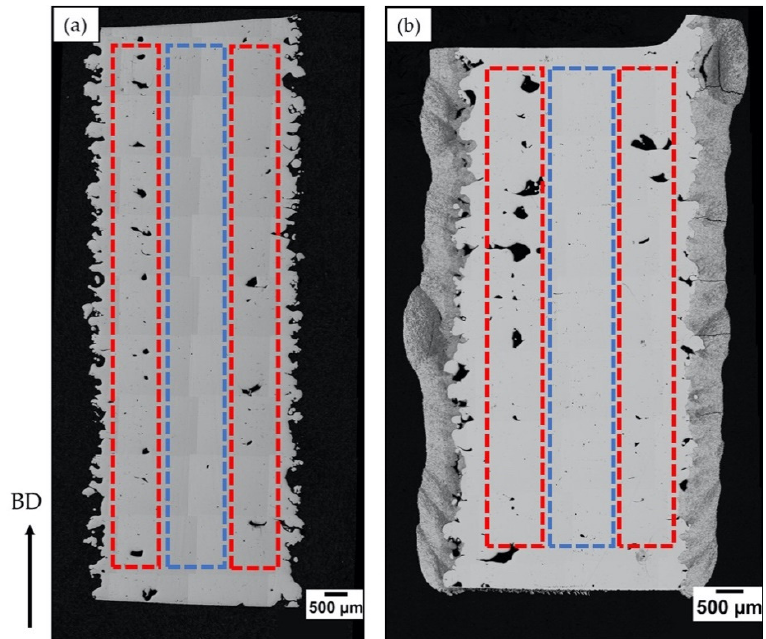
Figure 2. Light optical microscopy (LOM) micrographs of the specimen cross-sections in the ( a ) uncoated and ( b ) coated conditions. The dotted red and blue lines indicate the regions of contour and hatch, respectively, distinctly analyzed for defect quantification. The arrow indicates the build direction.